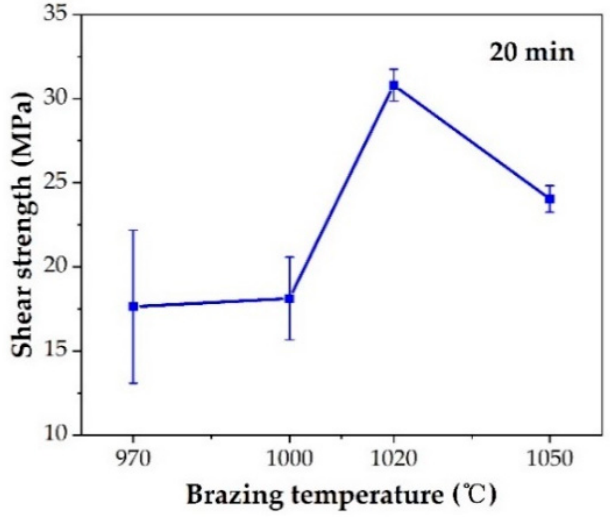
Figure 11. Effect of brazing temperature on shear strength.